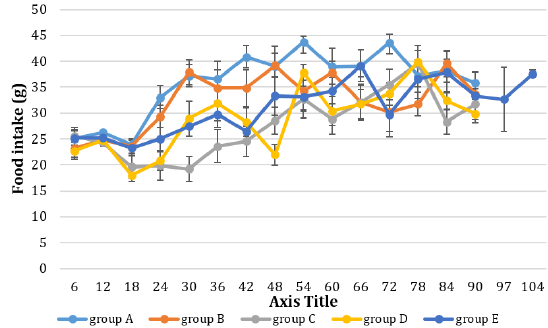
Figure 1. Mean body weight change in mice treated with 300 (group 2), 2000 (group 3), and 5000 mg/kg/d DPP (group 4) as compared with the control group (group 1) during acute toxicity study (P>0.05) (Pridiyanto, 2016).